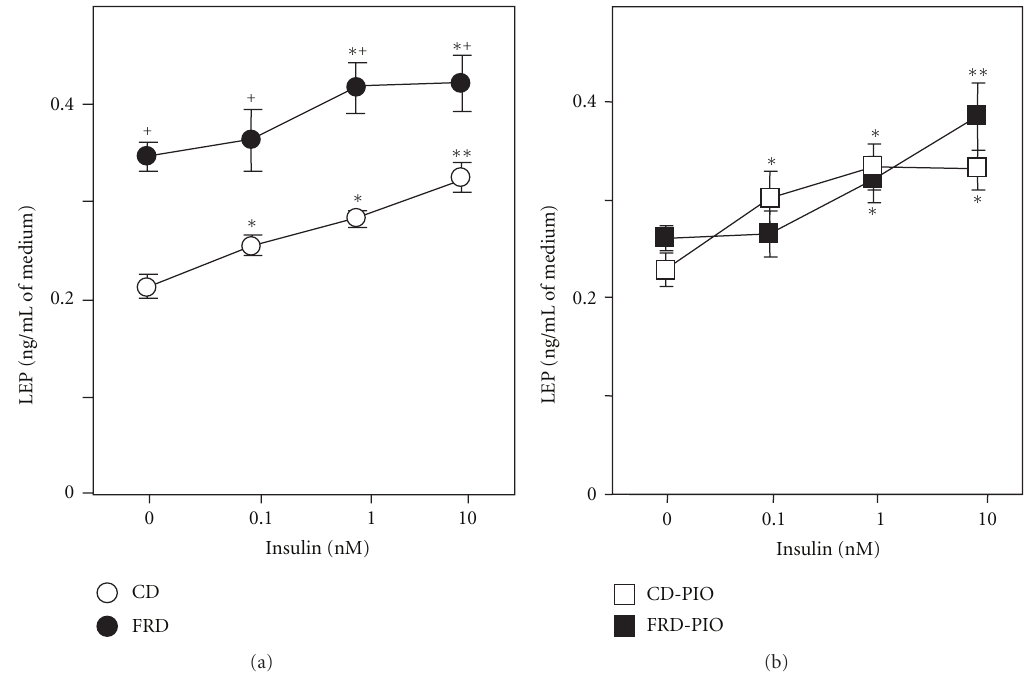
Figure 2: E ff ects of increasing concentrations of insulin on leptin release by adipocytes isolated from AAT of untreated CD and FRD rats (a) and from CD-PIO and FRD-PIO rats (b). Means ± SEM ( n = 5 di ff erent experiments, with 6 replicates per condition). ∗ P < 0.05 versus respective 0nM insulin; ∗∗ P < 0.05 versus 0.1 nM insulin; + P < 0.05 versus CD or CD-PIO in similar